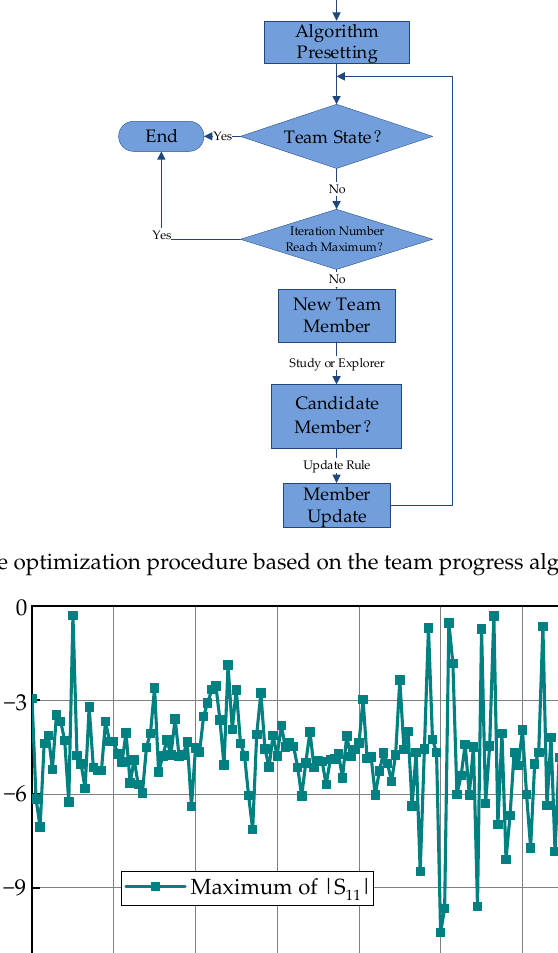
Figure 3. The optimization procedure based on the team progress algorithm (TPA).